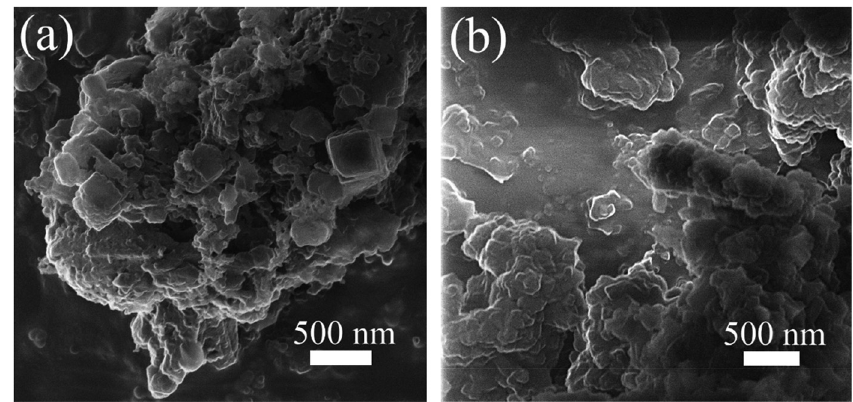
Figure 4: SEM images of ( a ) TBrTh – BTBPE – CTF and ( b ) CTF –